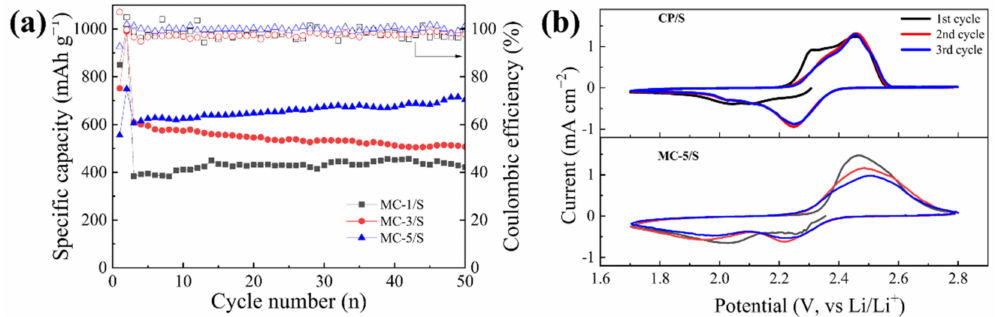
Figure 4. ( a ) Cycle performance of the Li–S batteries using MC-1, MC-3, and MC-5. Cyclic voltammo- grams of the Li–S batteries with CP and MC-5 as collectors ( b